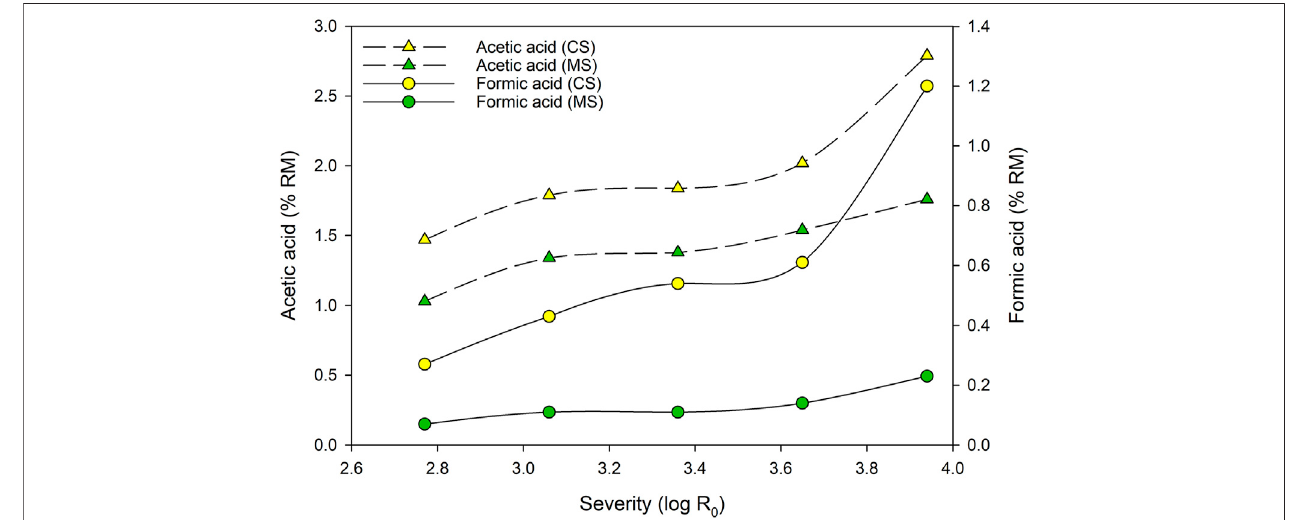
FIGURE 3 | Effect of steaming severity on the acetic and formic acid content of CS and MS fi ltrates.